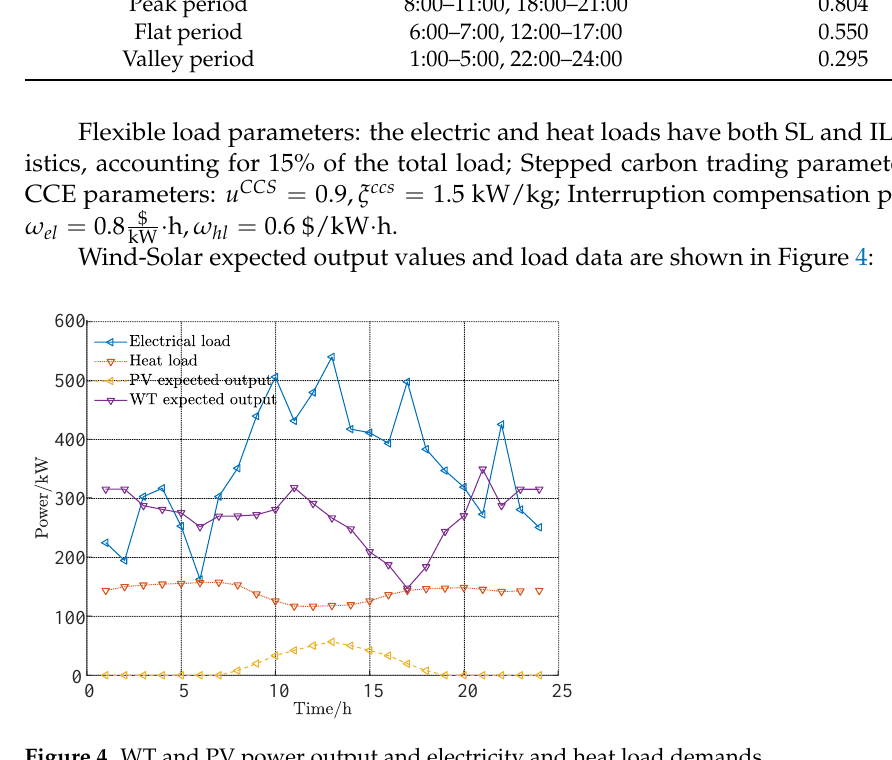
Figure 4. WT and PV power output and electricity and heat load demands.